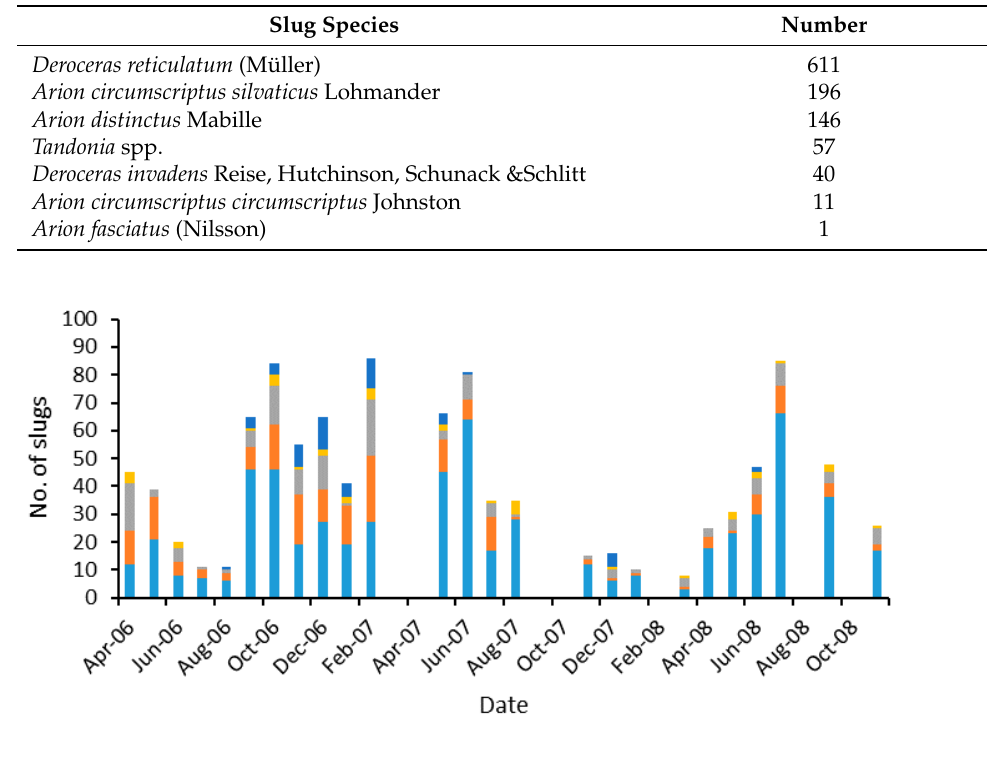
Table 1. Total numbers of different slug species collected from traps at a grassland site over 32 months.